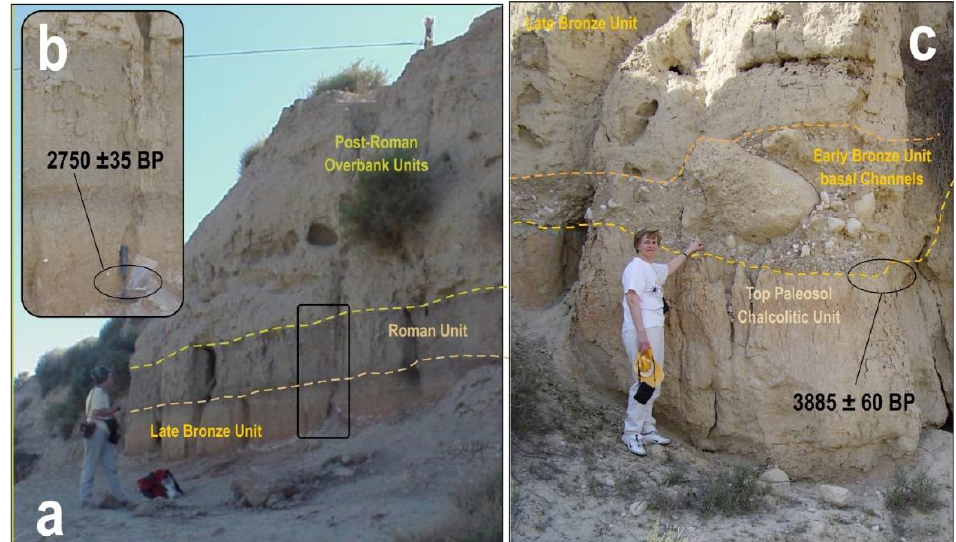
Figure 7. Soil/erosion relationships of different sedimentary units downstream the studied sequence. ( a ) Ventas del Rio Sequence and ( b ) detail of the dated gastropods level in the Bronze Age unit. ( c ) Erosional contact between the Bronze and Chalcolithic units in the Guadalentín – Librilla rambla junction displaying the approximate site of dating. Photo courtesy of Maryvonne Calmel- Á vila.